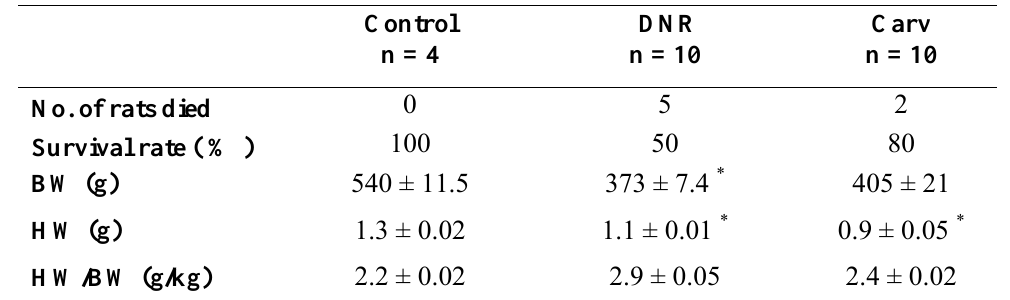
Table 1. Changes in survival rate and HW/BW ratio after 6 weeks of treatment with carvedilol in DNR rats.